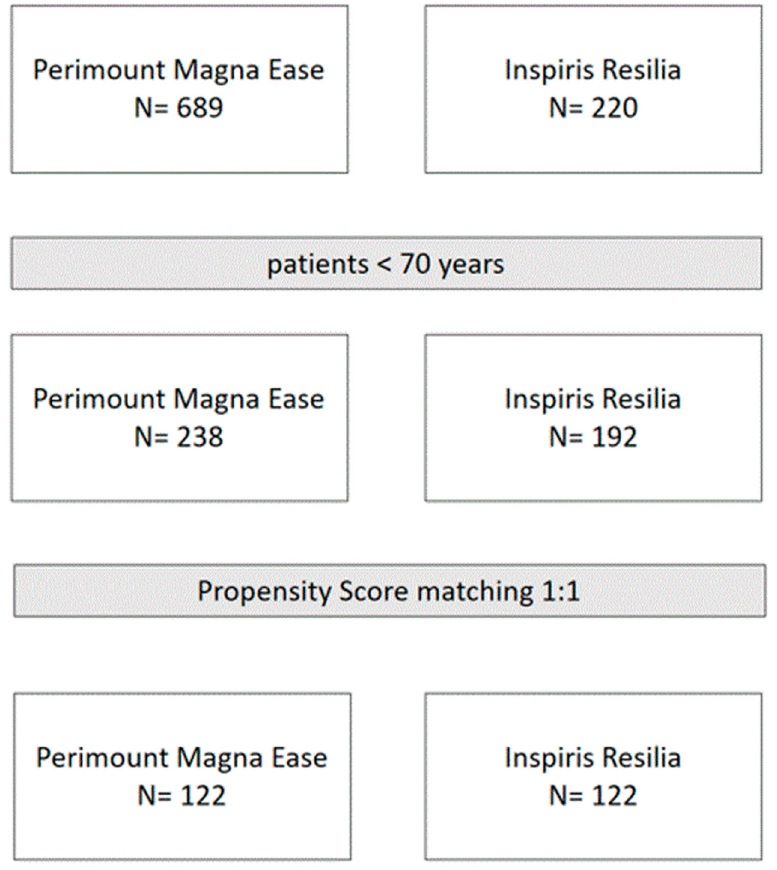
Figure 1. Consort diagram of study population.